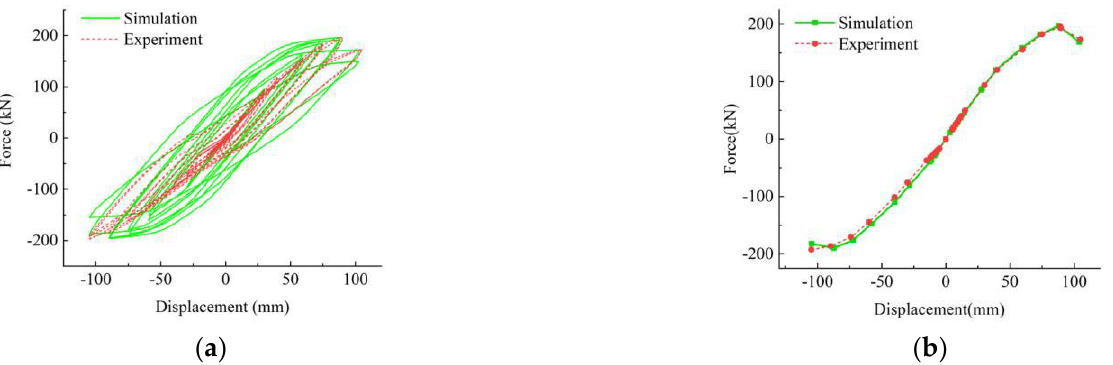
Figure 19. Comparison of test and simulation data. ( a ) Hysteresis curves of simulation and experi- ment. ( b ) Skeleton curves of simulation and experiment.